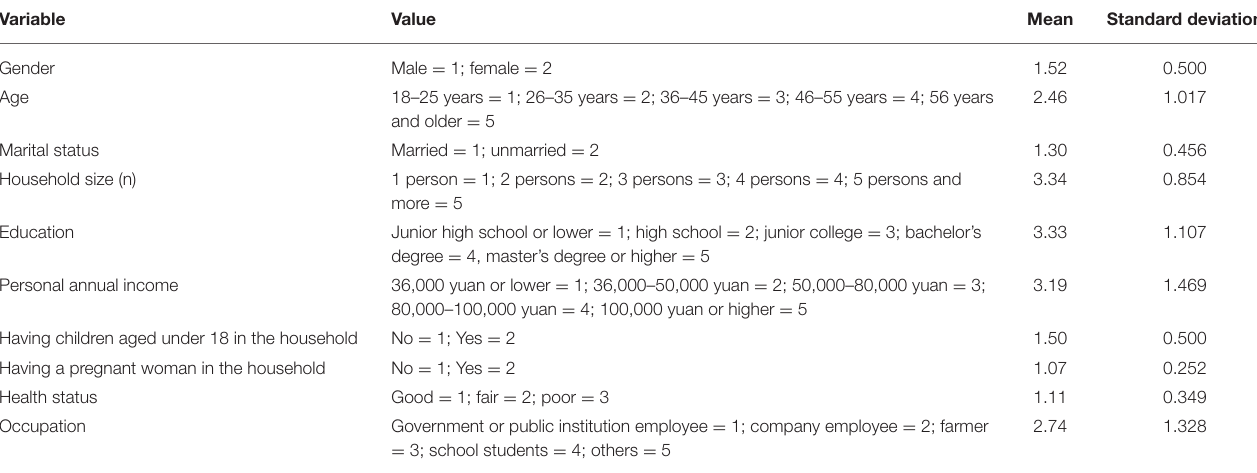
TABLE 2 | Independent